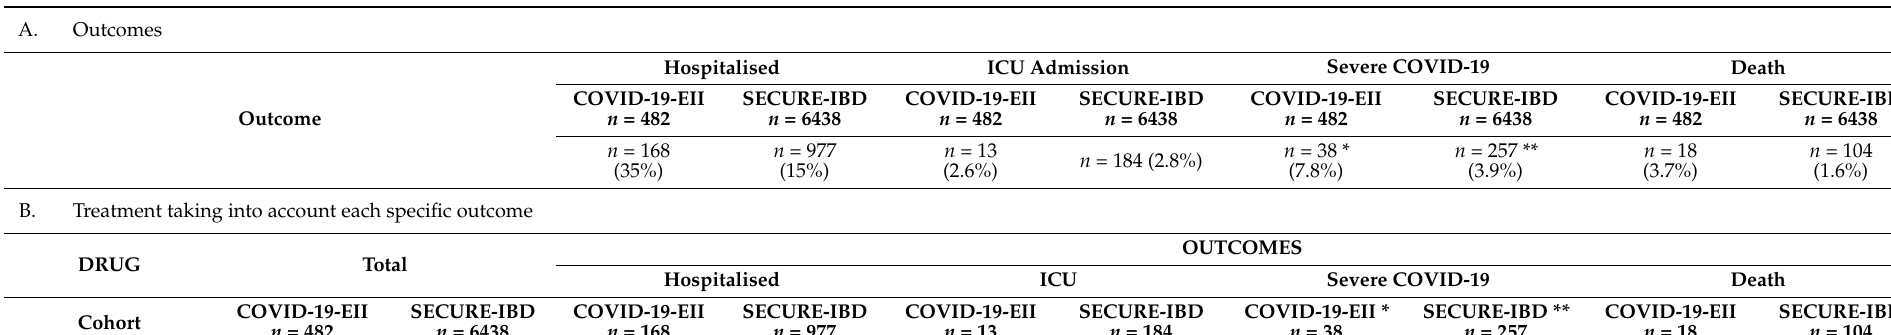
Table 5. Outcome of the COVID-19-EII cohort and treatment administered. The results are compared with those reported in the SECURE-IBD cohort (as for 24 August 2021) [9] ¶